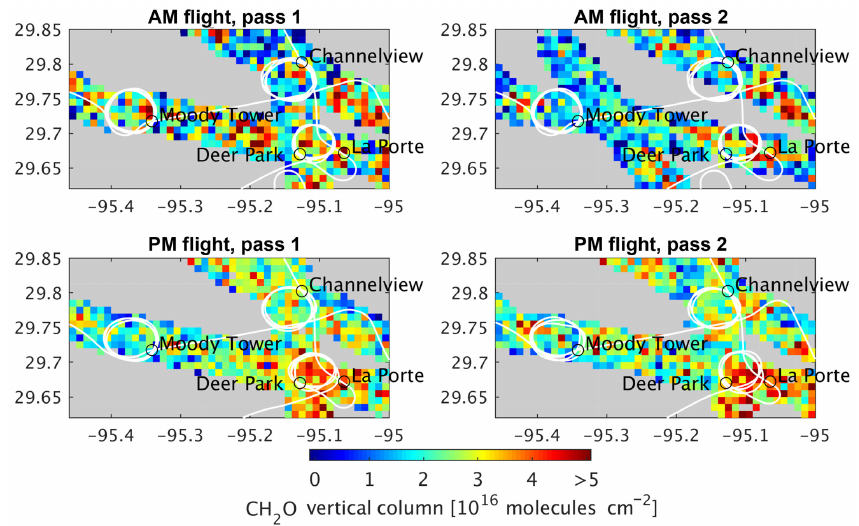
Figure 6. GCAS tropospheric CH 2 O columns measured near DISCOVER-AQ ground sites in the area of downtown Houston on 25 Septem- ber 2013. P-3B flight tracks are shown in white. CH 2 O columns are spatially averaged on a 0 . 01 ◦ × 0 . 01 ◦ grid ( ∼ 1km 2 ). The CH 2 O precision at this resolution is ∼ 7 × 10 15 moleculescm − 2